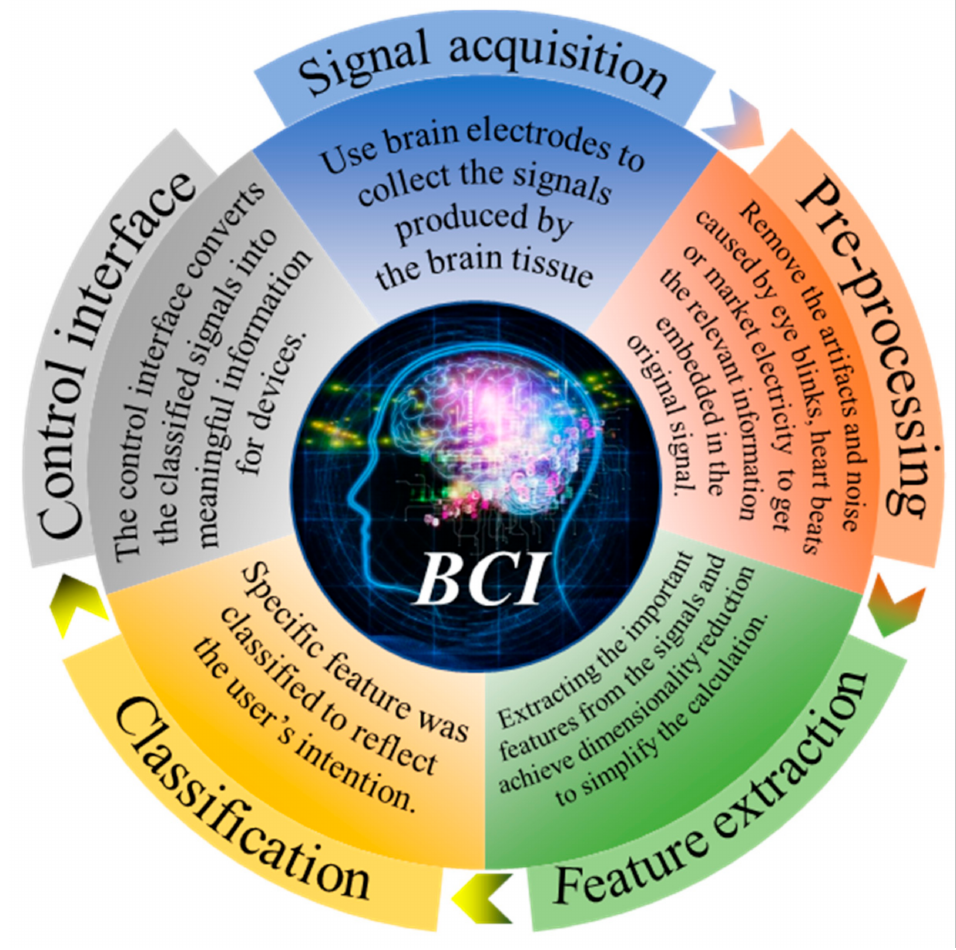
Figure 1. Five components of BCI